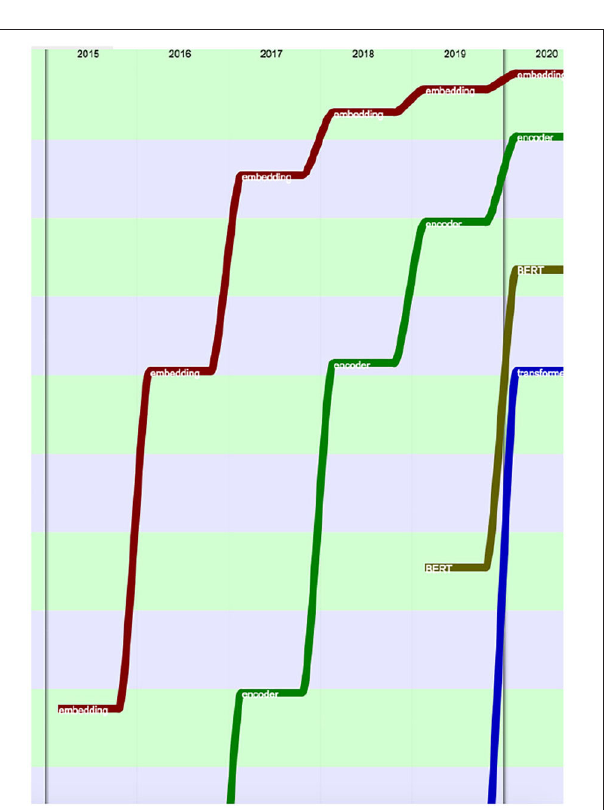
FIGURE 35 | Evolution of the terms “embedding” (red), “encoder” (green), “BERT” (brown) and “transformer” (blue) over the past 5 years (from the 100th rank in 2015 to the 40th in 2020), according to their